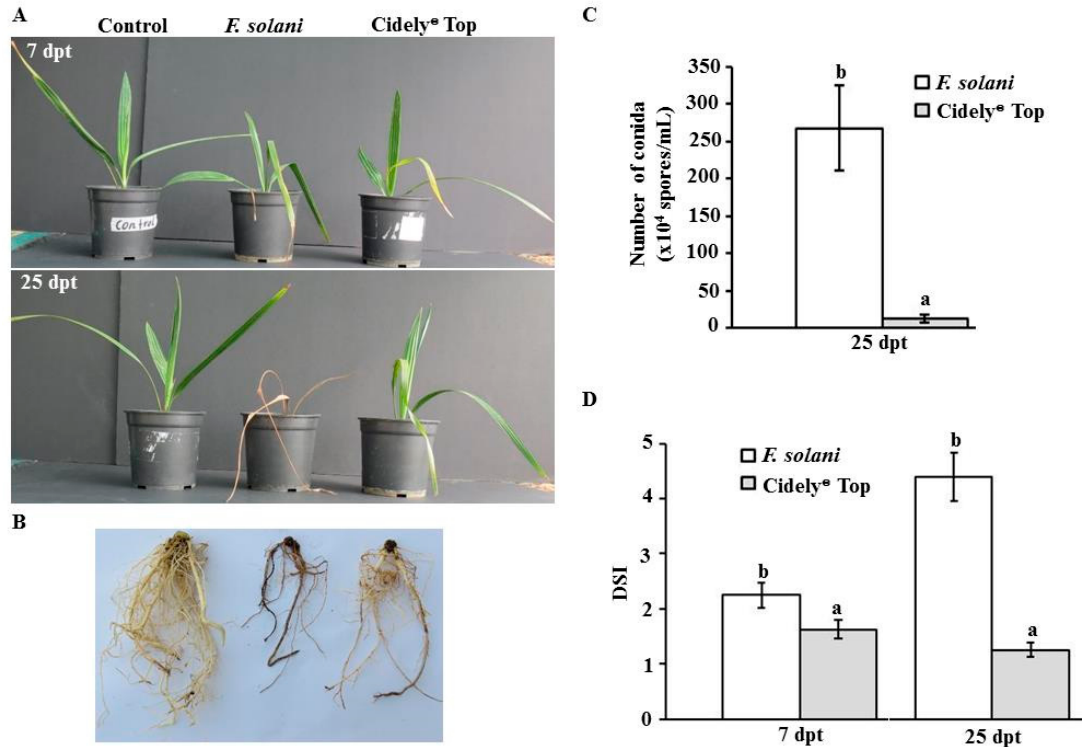
Figure 6. Effect of fungicide treatments on artificially inoculated date palm seedlings with F. solani in the greenhouse. Fungicidal suppression of Fusarium wilt disease on date palm seedlings cv. Barhi using Cidely ® Top fungicide at 7 (top panel) and 25 (bottom panel) dpt ( A ); recovery of root tissues previously infected with F. solani using 250 ppm of Cidely ® Top fungicide after 25 dpt ( B ). Number of conidia ( × 10 4 spores/mL) ( C ) and disease severity index (DSI) ( D ) after the application of Cidely ® Top on date palm seedlings infected with F. solani ( n = 12). In ( D ), DSI is on a scale of 5: 0 = no infection, 1 = 1–10%, 2 = 11–25%, 3 = 26–50%, 4 = 51–75%, and 5 = 76–100% damage including necrosis, white area in leaves or rotting in roots. In (C–D) Values with different letters are significantly different from each other at p = 0.05. In (A–D), seedlings inoculated with F. solani at 10 days before the fungicide